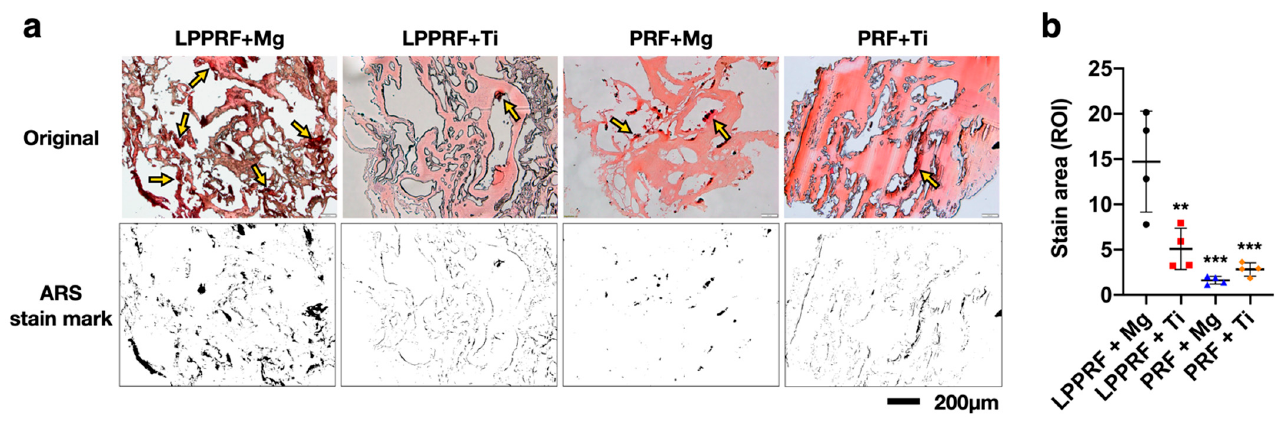
Figure 11. ( a ) Calcium deposition of MC3T3-E1 preosteoblasts on platelet-rich fibrin and large-pore platelet-rich fibrin with magnesium and titanium rings, as detected through alizarin red S staining on the scaffold with 5- μ m-thick sections. The location of calcium deposits is indicated by a yellow arrow. ( b ) Quantitative results of stain marks, obtained using Image J software. (N = 4 per group; ** p < 0.01, and *** p < 0.005).